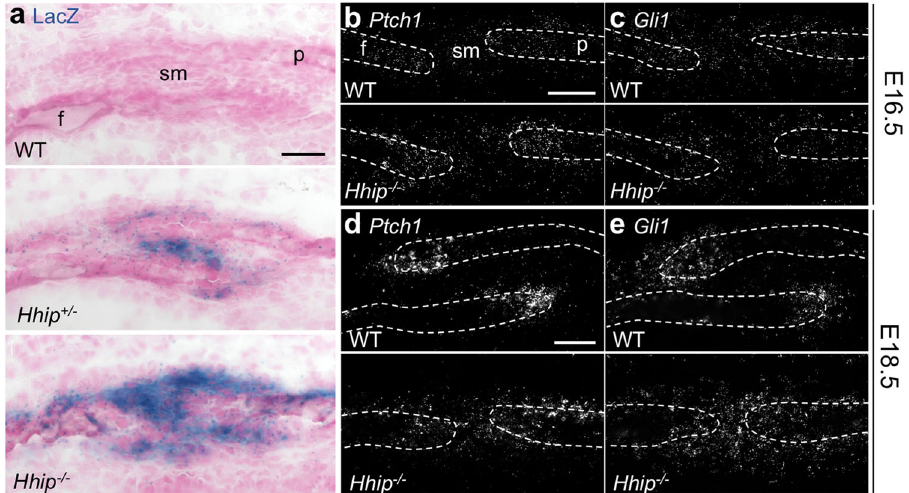
Fig. 9 Altered HH signaling in the Hhip − / − coronal suture. a LacZ staining (blue) in WT, Hhip + / − , and Hhip − / − coronal sutures at E18.5, counterstained with nuclear fast red. b – e smFISH for b , d Ptch1 , and c , e Gli1 in WT and Hhip − / − coronal sutures at b , c E16.5 and d , e E18.5. Dashed outlines indicate frontal (f) and parietal (p) bones; sm, suture mesenchyme. Sections are in the transverse plane. Results presented in a are representative of n = 2 WT, two Hhip + / − , and two Hhip − / − independent samples. Results presented in b – e are representative of n = 3 WT and three Hhip − / − independent samples. Scale bars, 50 μ